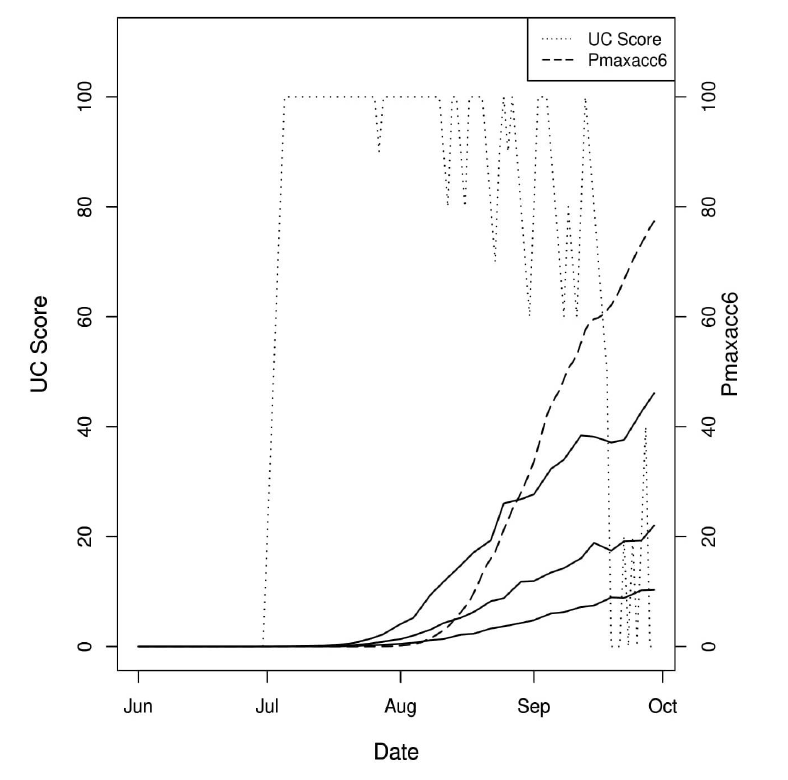
Figure 12. Fungicide spray programs of the UC-Davis and the degree-days risk assessment model to grape PM in 2011. The dotted line indicates the threshold-based UC score from the UC-Davis model. The long dashed line indicates the schedule-based model scores from the degree-day model. The solid line indicates the DI of Chancellor (top); Geisenheim-318 (middle); and Frontenac